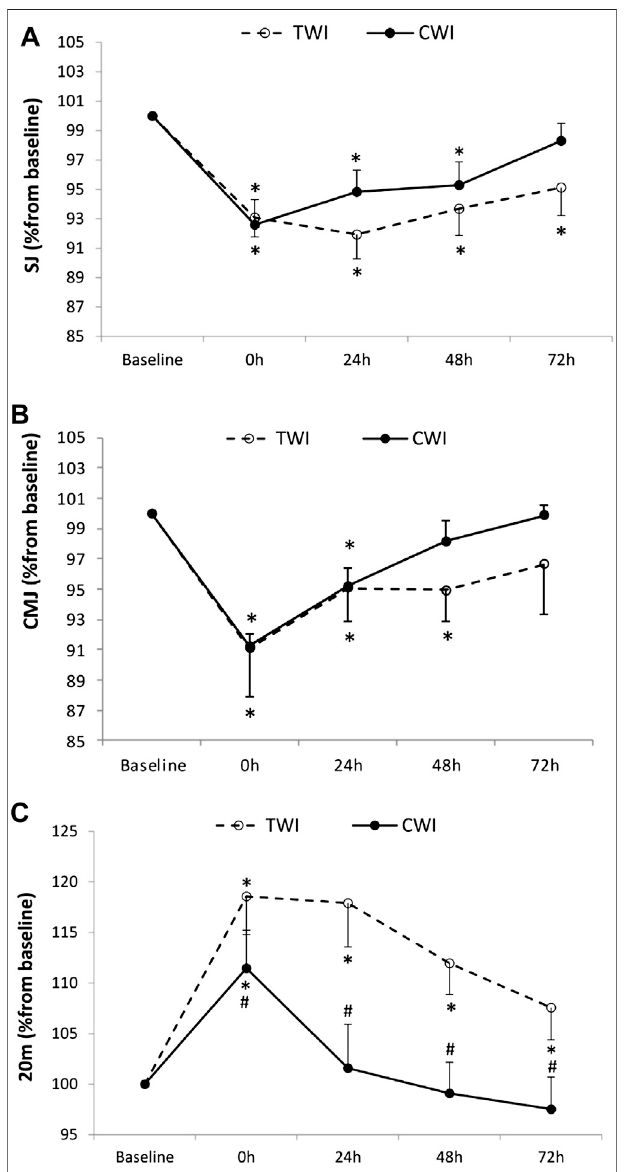
FIGURE3| Squatjump(SJ) (A) ,countermovementjump(CMJ) (B) ,and 20 m sprint (C) values measured at baseline and following the match (post, 24h, 48h and 72 h) after cold water immersion (CWI) or thermoneutral water immersion (TWI). *Signi fi cant difference in comparison to baseline ( p < 0.05). # Signi fi cant difference in comparison to TWI ( p < 0.05).